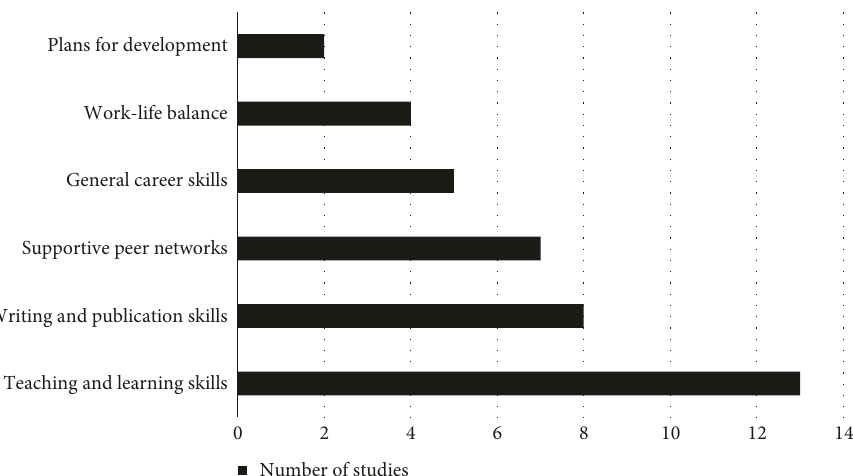
Figure 2: Prevalence of themes identified in the